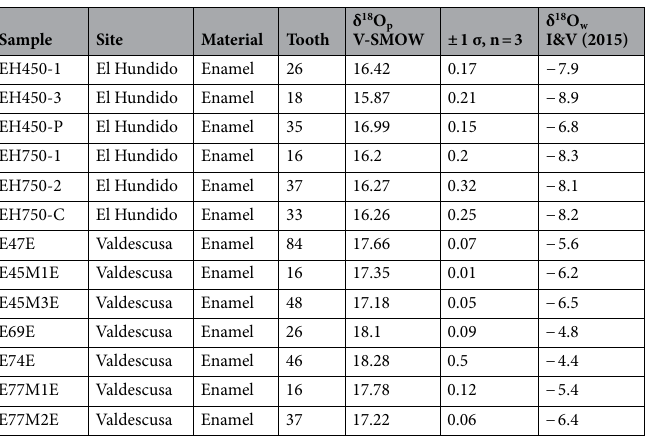
Table 3. Stable oxygen isotope data reported as δ 18 O p of the phosphate group of bioapatite and water.